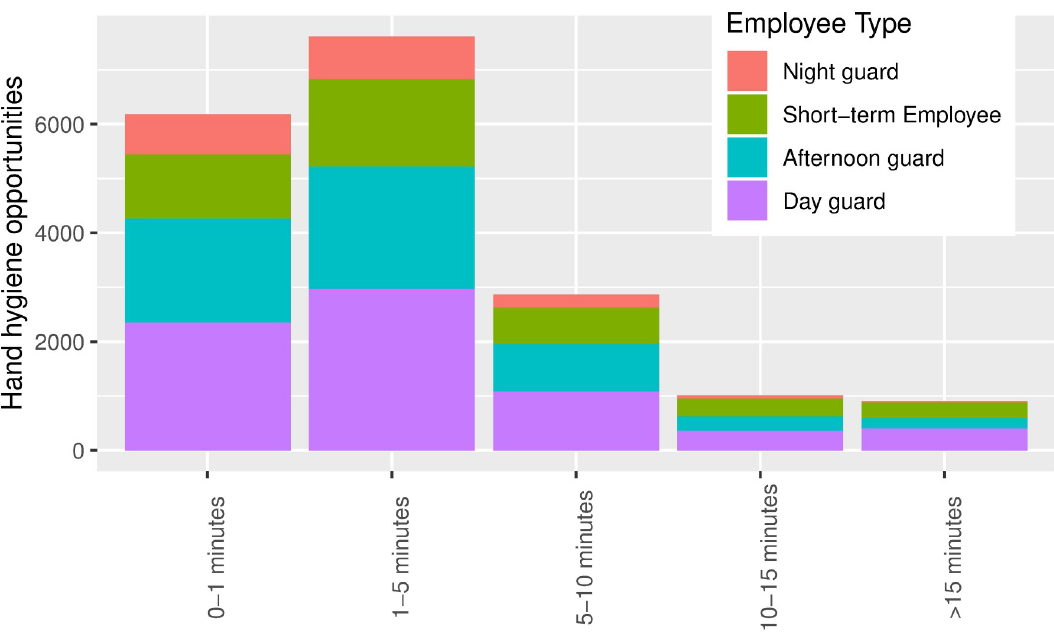
Fig 4. Distribution of encounter duration of the different types of HCW at S ø lund nursing